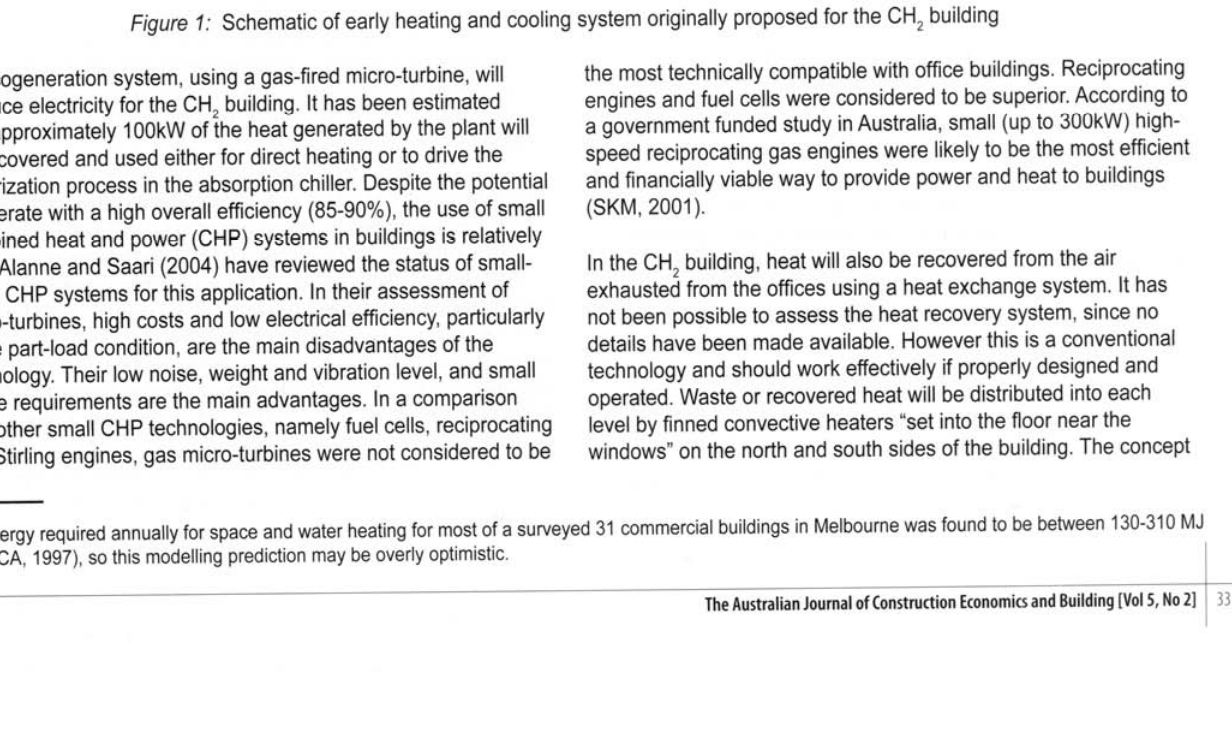
Figure 1: Schematic of early heating and cooling system originally proposed for the CH